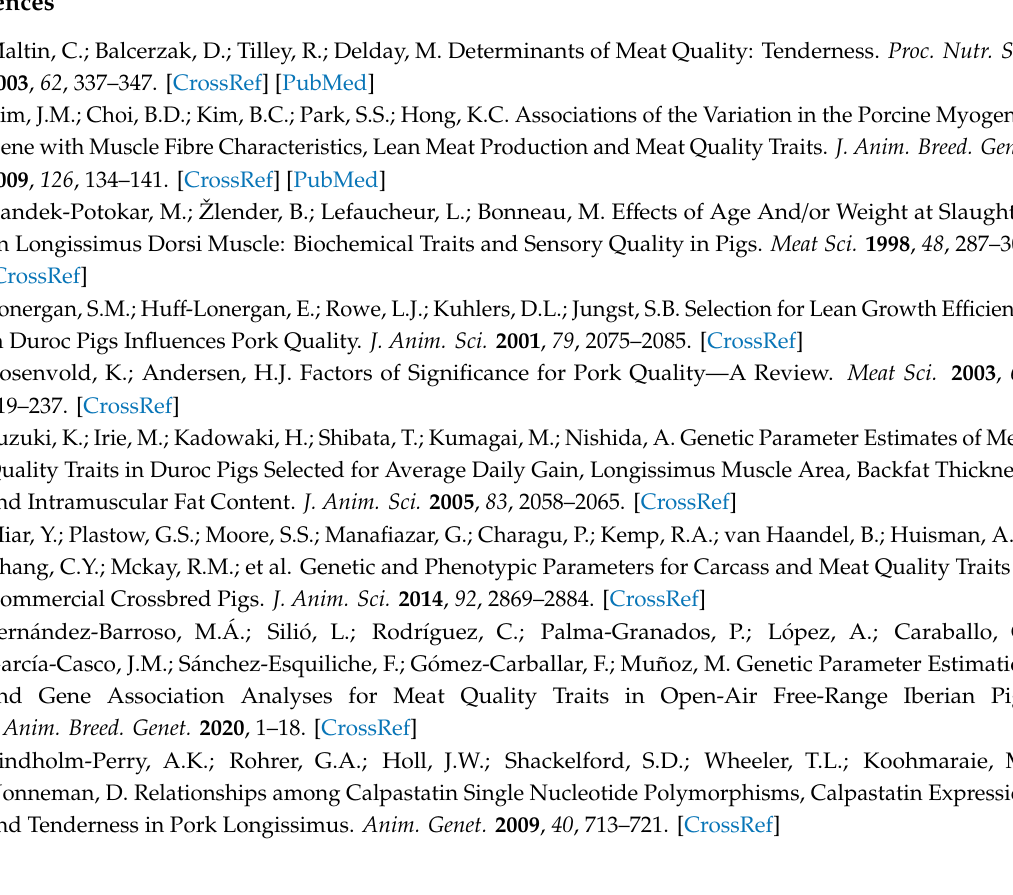
Tender and Tough groups, Table S8: Ingenuity Pathway Analysis (IPA). List of upstream regulators identified in the set of DEGs according to the Tender and Tough group ( p -value < 0.05). PAS: Predicted activation ratio. Figure S1: Gene expression distribution of the 25,878 genes annotated in the pig genome (Sscrofa11.1) in fragments per kilobase of transcript per million mapped fragments (FPKMs) normalized values corresponding to the animals with the highest EBV for shear force and tougher meat (High EBV SFF) and the lowest EBV for shear force and tenderer meat (Low EBV SFF). Figure S2: Network of protein–protein interactions predicted with the STRING database. Same color nodes sharing multiple edges are grouped in the same cluster. Figure S3: Gene network #8: Cardiovascular System Development and Function, Cell Cycle, Gene Expression. Genes upregulated and down-regulated in the Tender group are represented in green and red colors, respectively. Figure S4: Gene network #9: Cell Cycle, Cellular Assembly and Organization, Cellular Movement. Genes upregulated and down-regulated in the Tender group are represented in green and red colors,